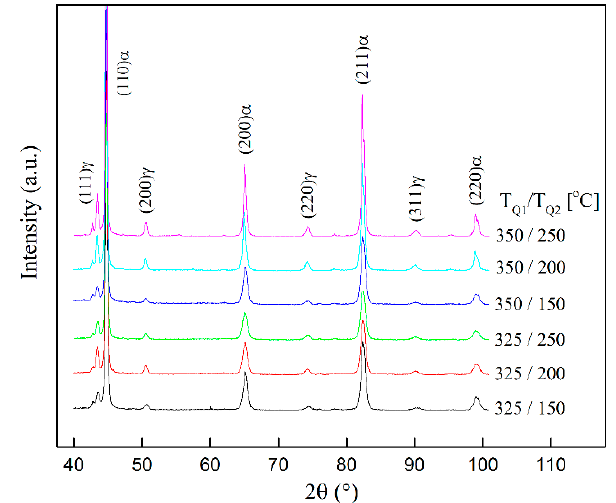
Figure 14. X-ray diffraction patterns of specimens treated with different quenching temperature of T Q1 and T Q2 . T P1 = 425 ◦ C, and the first partitioning time is 10 s; T P2 = 350 ◦ C, and the second partitioning time is 10 s.